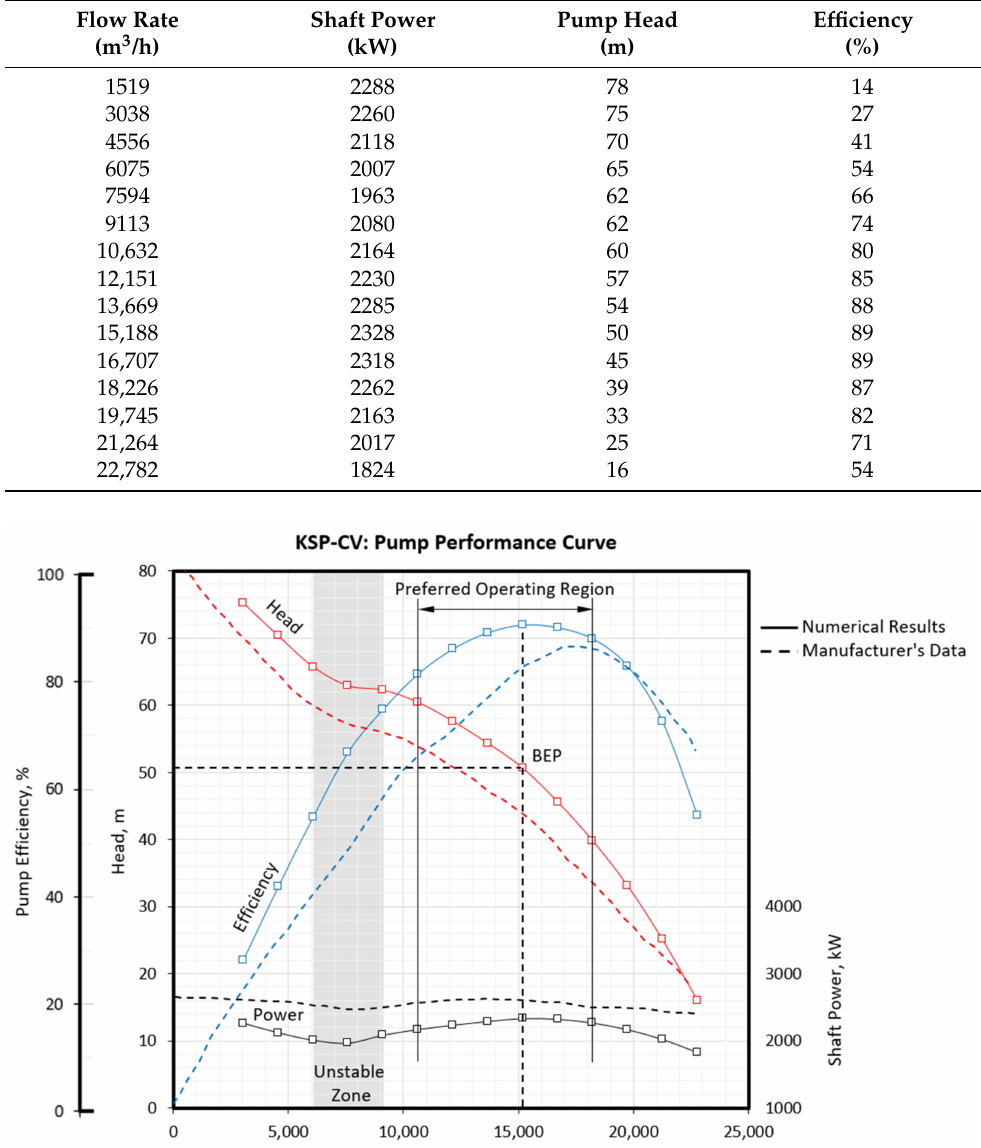
Table 3. Tabulated performance results for mixed-flow pump at 600 RPM.